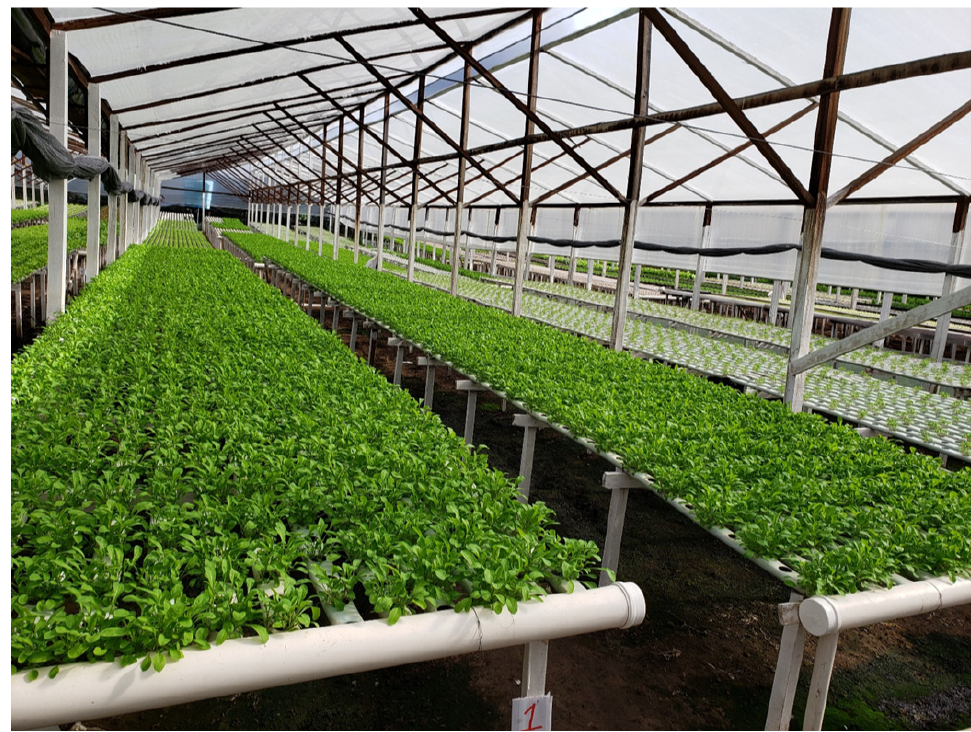
Figure 5. Internal image of greenhouses with hydroponic cultivation.